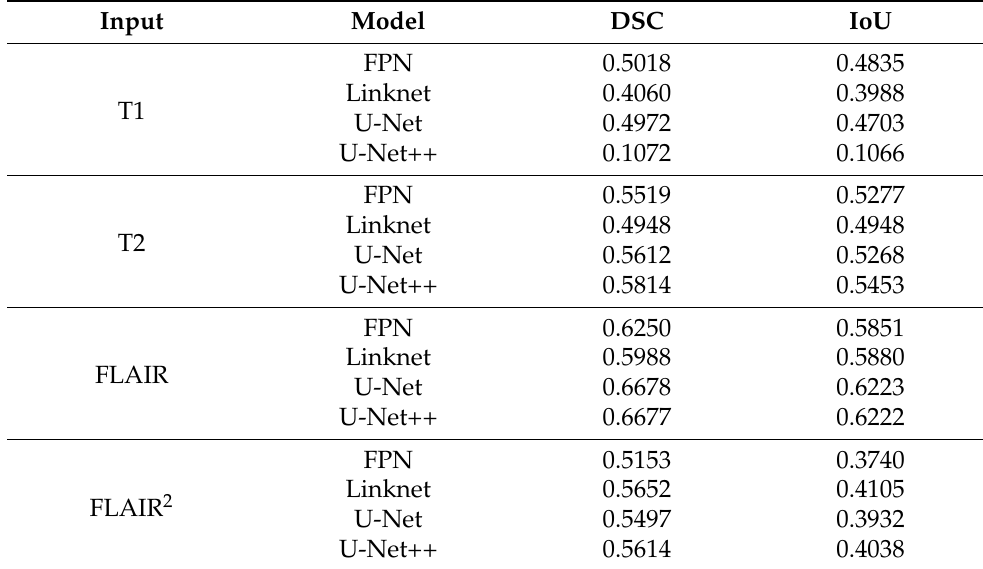
Figure 4. U-Net with ResNeXt-50 training with FLAIR sequence. Shown are the DSC, IoU, and loss per epoch during training. Table 3. Testing Metrics Using UMCL